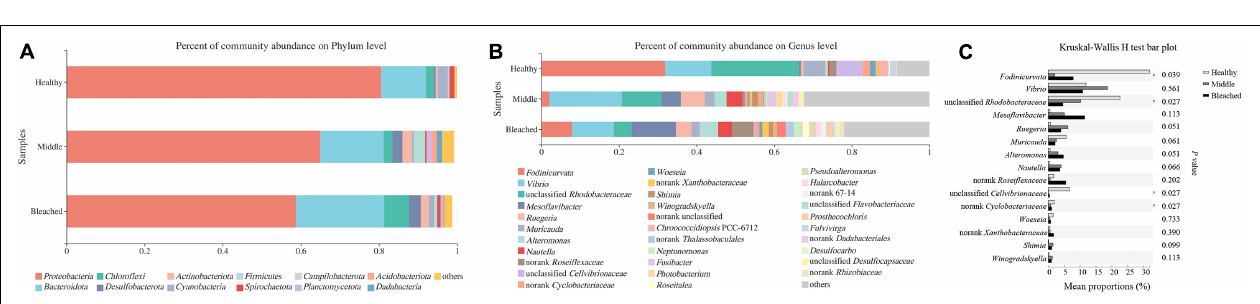
FIGURE 3 | Richness and alpha diversity of bacterial communities associated with P. onkodes based on (A) Shannon index, (B) Ace index, and (C) Simpson index. ∗ p ≤ 0.05, ∗∗ p ≤ 0.01, and ∗∗∗ p ≤ 0.001.